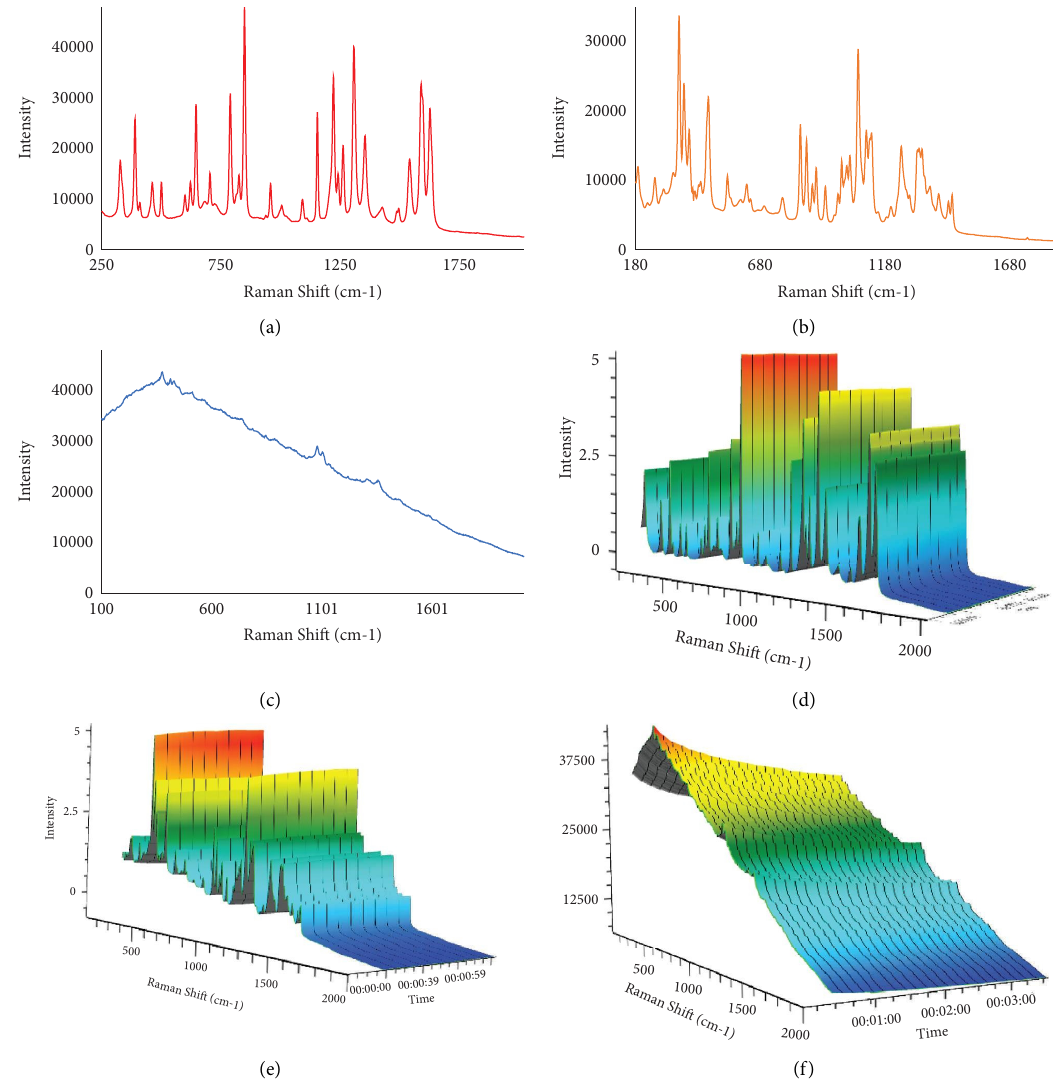
Figure 2: (a) Raman spectra of APAP, (b) Raman spectra of lactose, (c) Raman spectra of MCC, (d) surface plot of Raman spectra of APAP, (e) surface plot of Raman spectra of lactose, and (f) surface plot of Raman spectra of